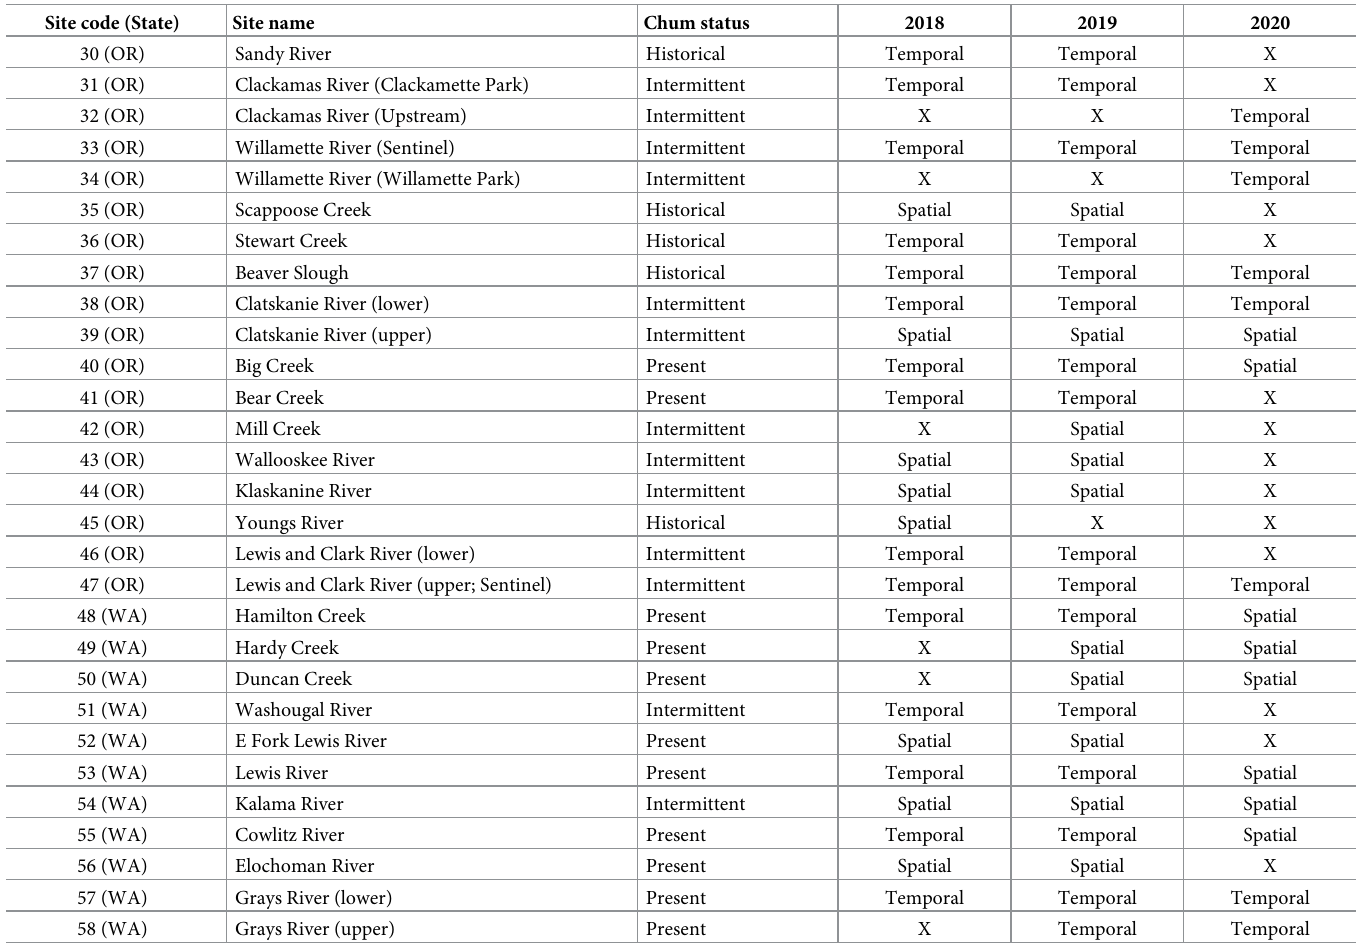
Table 2. Site code, site name, status of chum salmon Oncorhynchus keta spawning (historically present; intermittently present, currently present), and sample type by year for tributary sites sampled for Ceratonova shasta , 2018–2020 in the lower Columbia River Basin. “X” indicates site not sampled during a given year. Site code